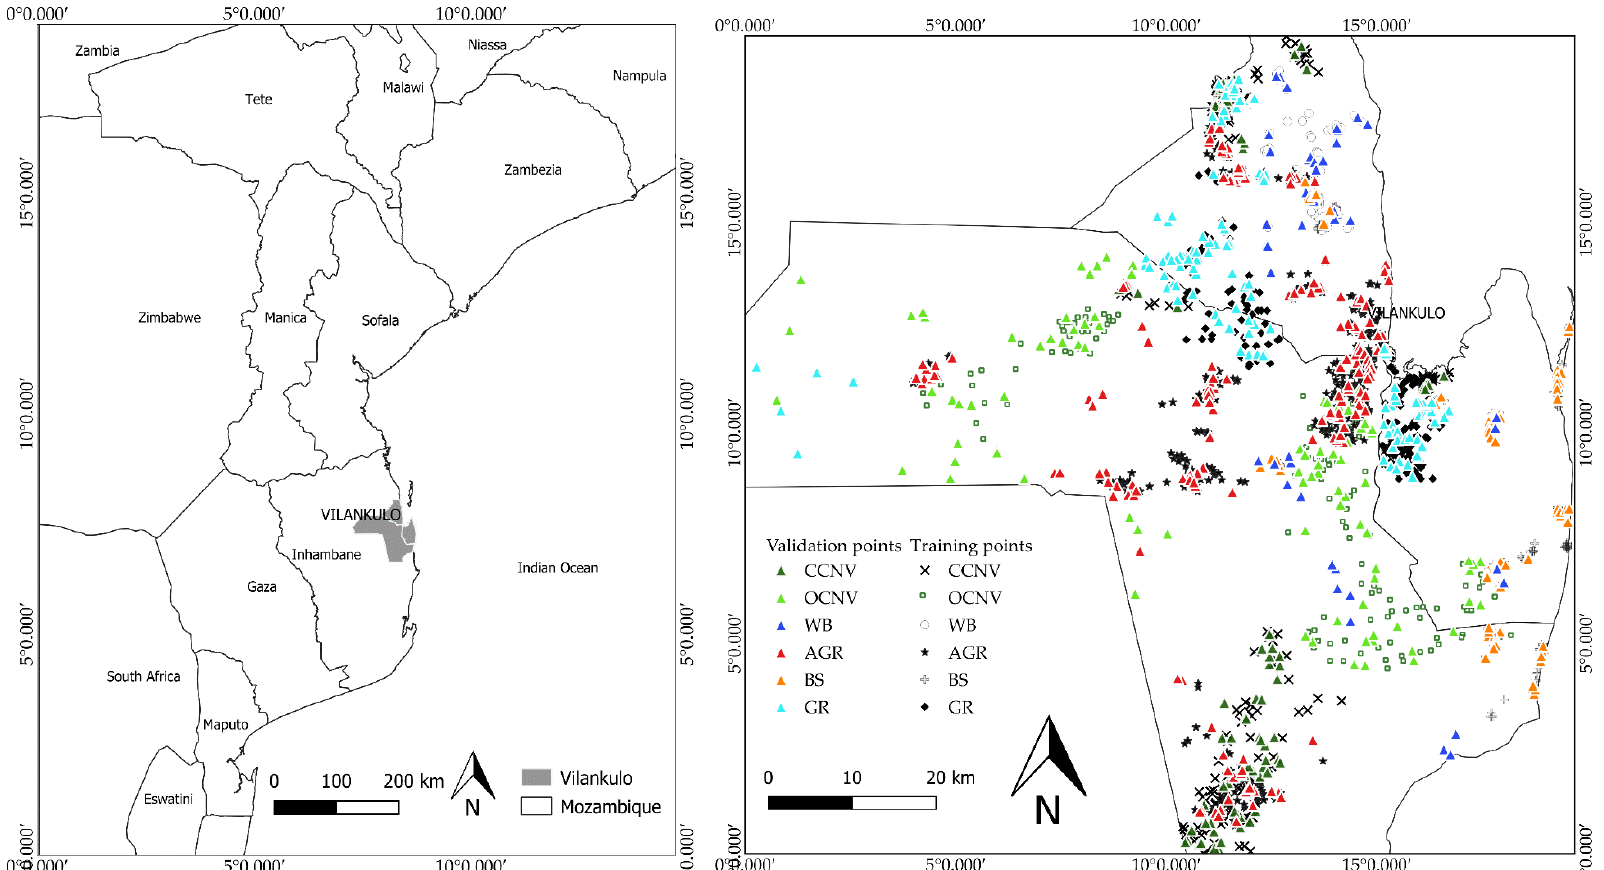
Figure 1. Location of Vilankulo district in Mozambique (left) and map of Vilankulo district (right) with location of the training and validation datasets. CCNV—close canopy natural vegetation; OCNV—open canopy natural vegetation; WB—water bodies; AGR—agriculture; BS—bare soils; GR—grassland.